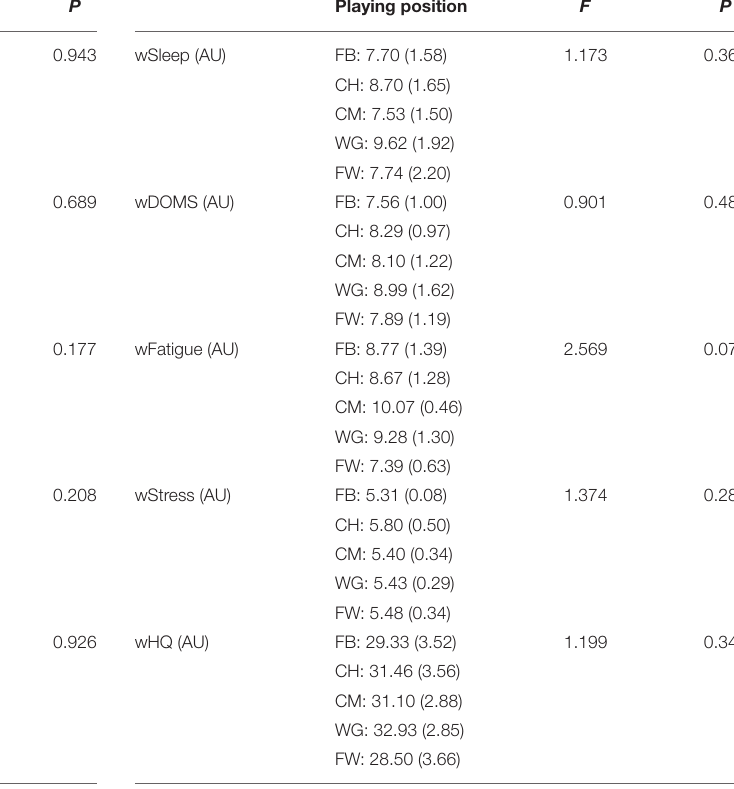
TABLE 3 | Outcomes of ANOVA for well-being variables during early-season, considering playing positions. Playing position F P